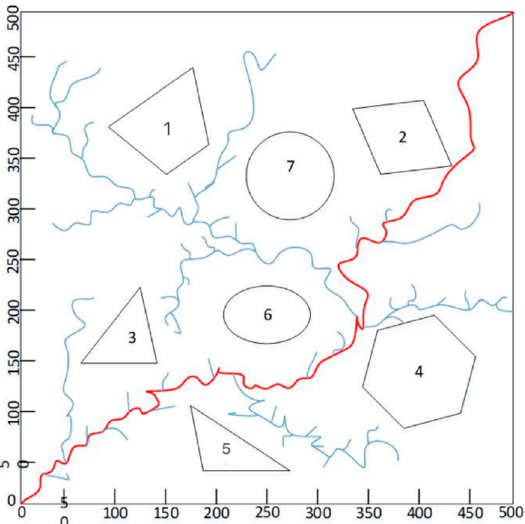
Figure 10 . Result of path planning based on RRT. The RRT algorithm is used for calculation. As shown in Figure 10, in the simulation experiment, the path planning time is 54 s, and the number of extended nodes reaches more than 2000; the number of nodes in the return path is 252. The overall calculation efficiency is low, and the final path is not a more scientific and reasonable path. (1) Path planning based on AV-RRT accords to the kinematical constraint condition.